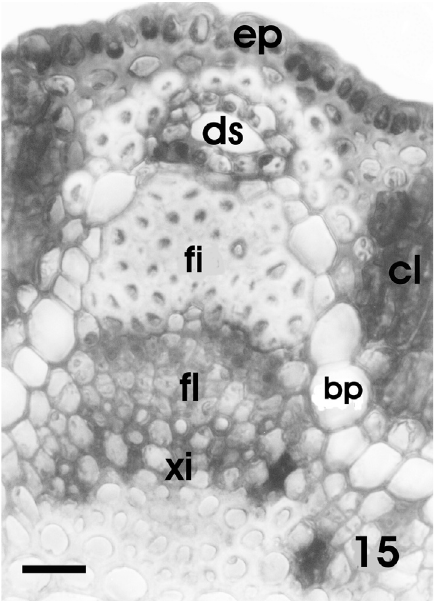
FIGURA 15 – B. trimera – Detalhe parcial do eixo do cladódio, em secção transversal. cl: clorênquima; ds: duto secretor; bp: bainha parenquimática; ep: epiderme; fi: fibras esclerenquimáticas; fl: floema; xi: xilema. Barra = 20 µ m.